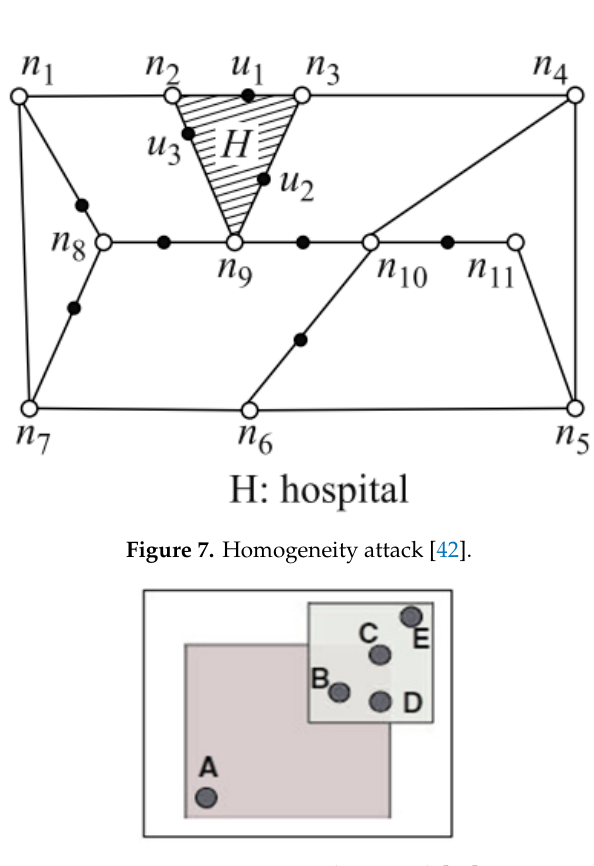
Figure 8. Query sampling attack [15].